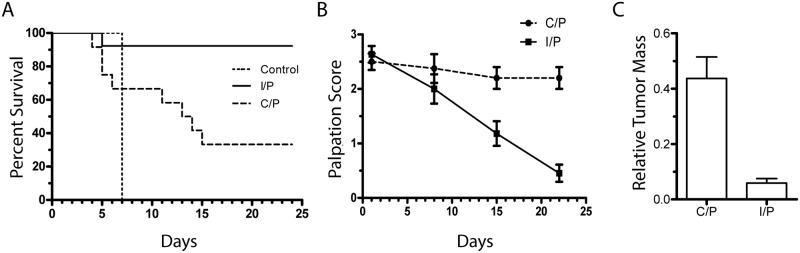
Tumorgraft response to treatment in vivo.Mice were randomized to receive (n = 13 each group) either saline, carboplatin and paclitaxel (C/P), or ifosfamide and paclitaxel (I/P). (A) Kaplan-Meier Curve demonstrates survival. The C/P and I/P curves were significantly different, log-rank test p = 0.0027. (B) Tumor palpation score over time reflects the change in tumor size with treatment. (C) Tumor weights in each cohort were normalized against the final mean control weight obtained at necropsy on day 7 (which represents the maximum-allowed tumor burden). The difference between C/P and I/P relative tumor mass was significant (two-tailed t test, p <0.0001).